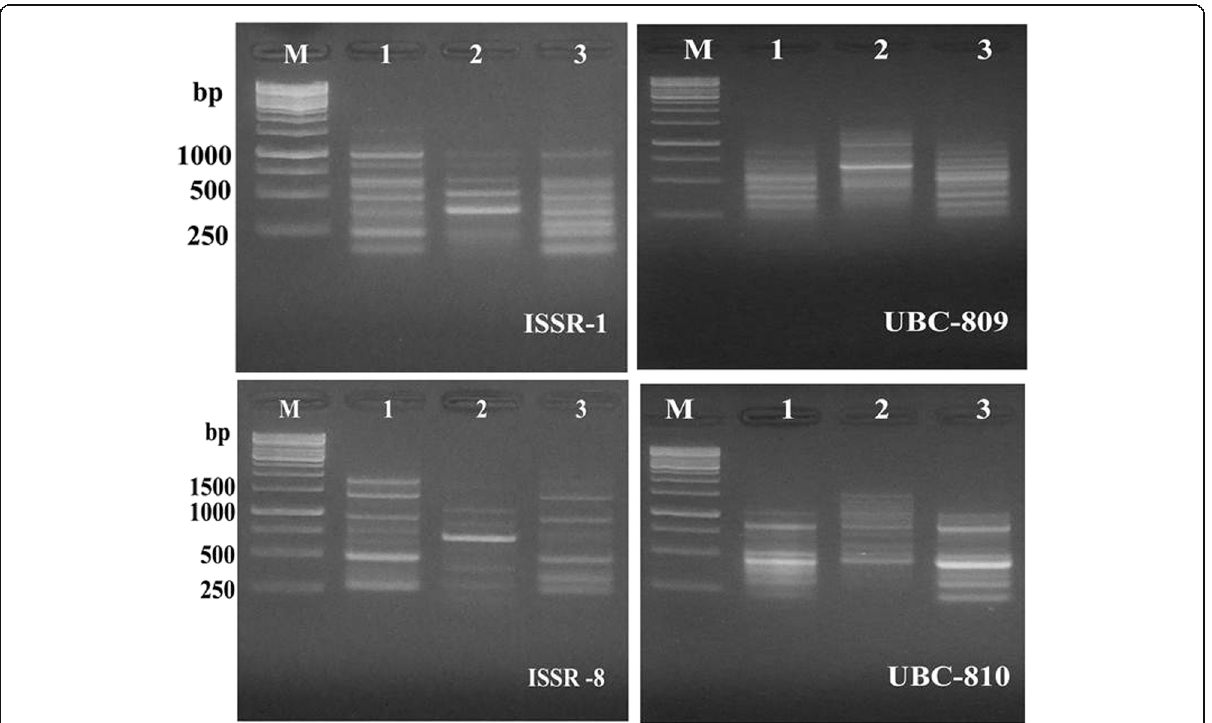
Fig. 3 Genetic polymorphism among the three isolates belongs to the family Heterorhabditis sp. as revealed by the ISSR analysis. M: 1 kbp plus DNA ladder; 1 – 3, the nematode isolates (1, ERSAG3; 2, ERSAG1; 3, ERSAG4)